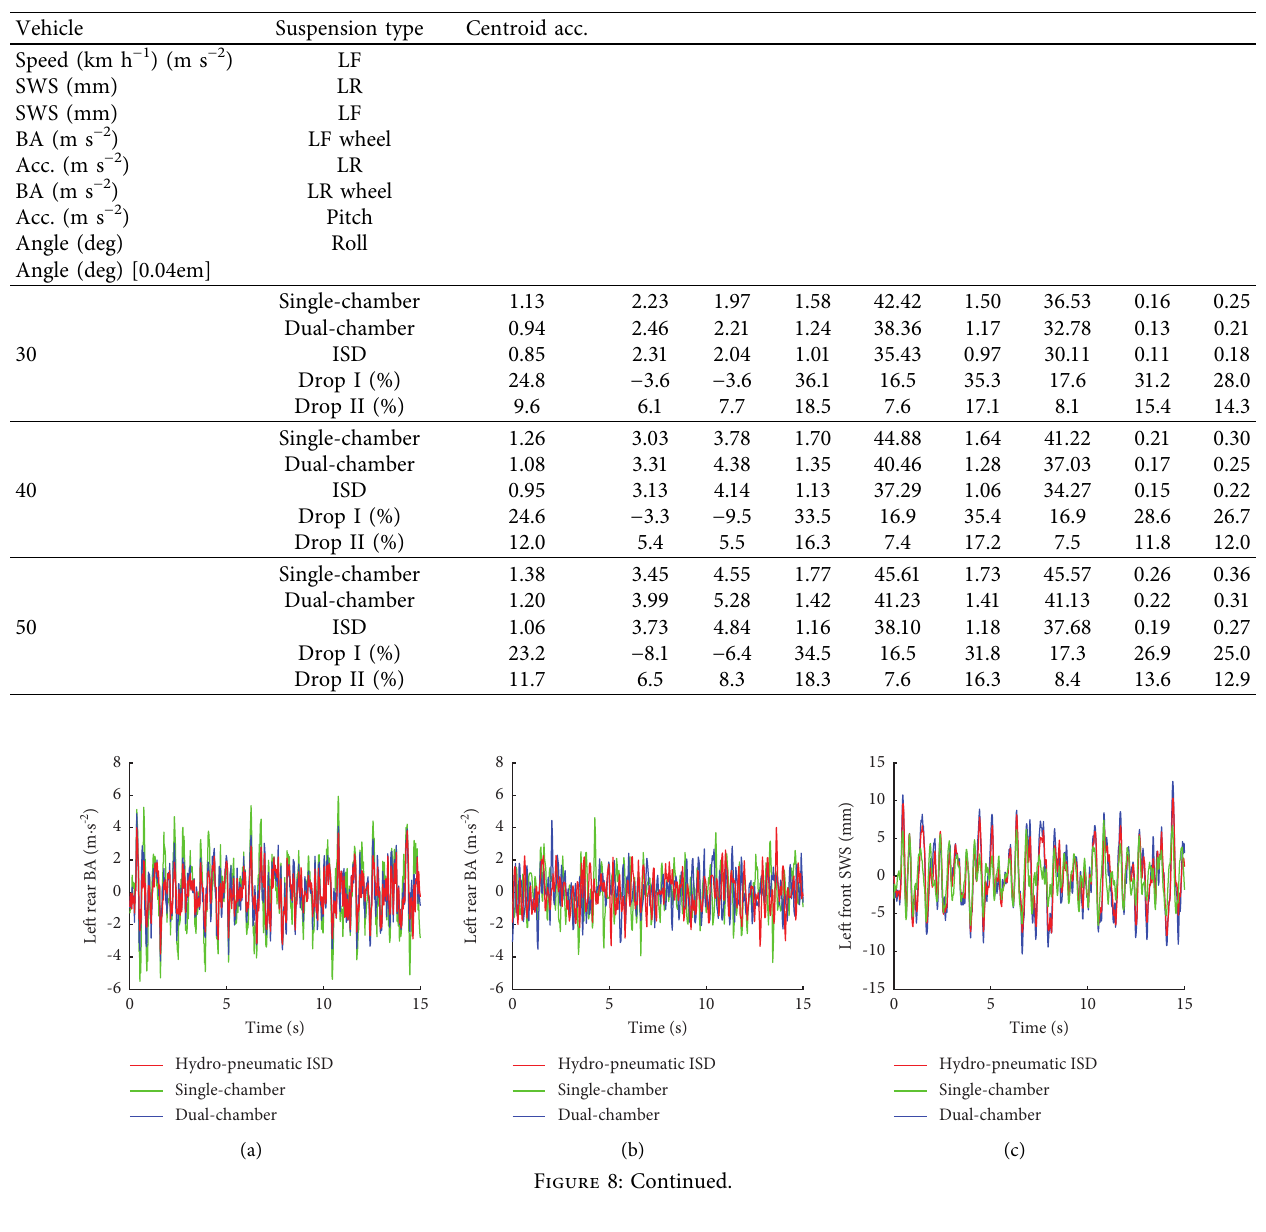
Table 6: RMS values of random input response for